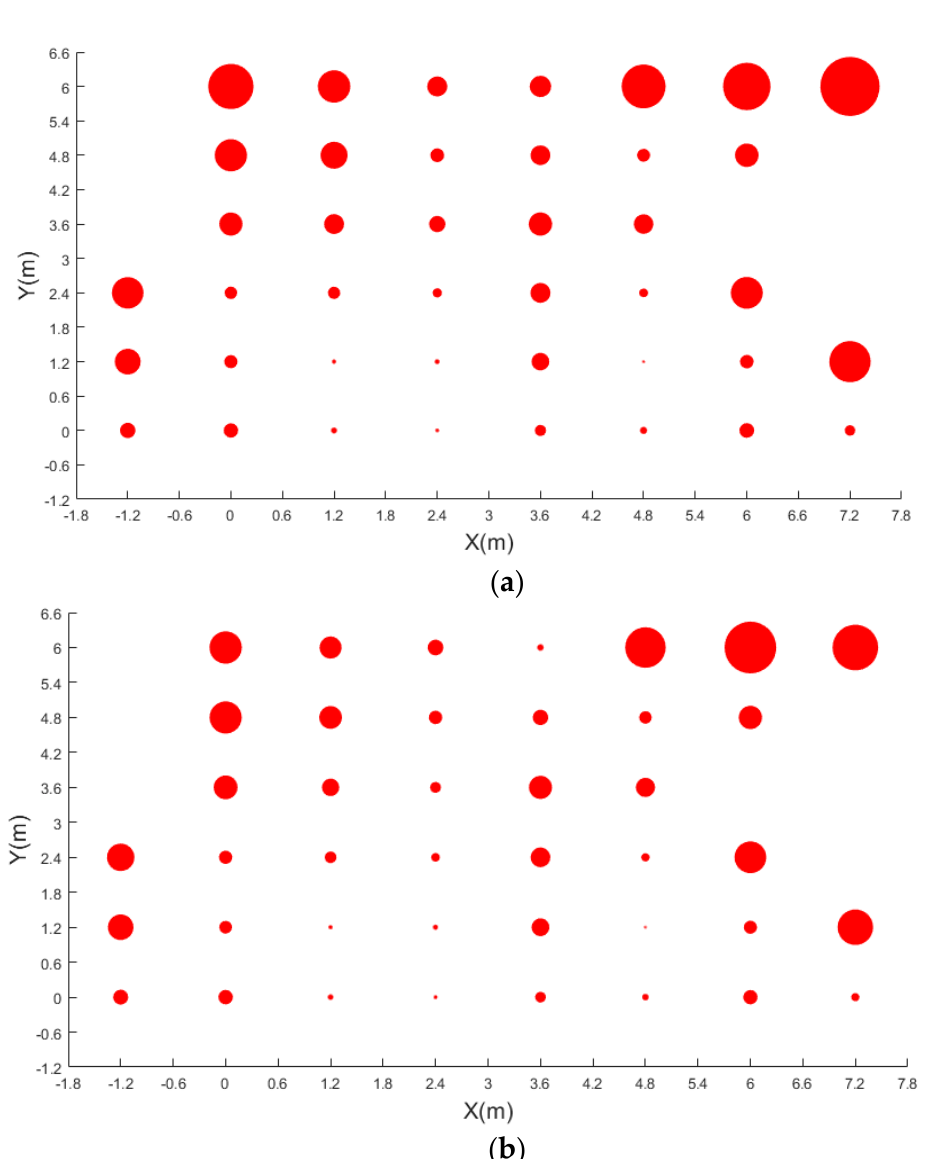
Figure 13. Position error of the 41 test-points. ( a ) Results by YOLOv3; ( b ) results by YOLOv3 + RIAM. As seen in Table 2, different points have different positioning accuracy. The minimum mean error of two detection methods are both test-point 26, and the maximum mean error of two detection methods are test-points 31 and 36. Test-point 26 is closest to the projection center and test-points 31 and 36 are far from the projection center. Among the 41 test-points of the passive visual positioning based on YOLOv3, there were 27 points with an average accuracy smaller than 0.5 m, while 37 test-points were smaller than 1 m. Moreover, there were 28 points with an average accuracy smaller than 0.5 m, while 39 test-points were smaller than 1 m based on YOLOv3 + RIAM. The results show that YOLOv3 + RIAM can achieve higher positioning accuracy in passive visual indoor positioning. Additionally, the positioning accuracy of passive vision can reach 1 m in 95% of the coverage